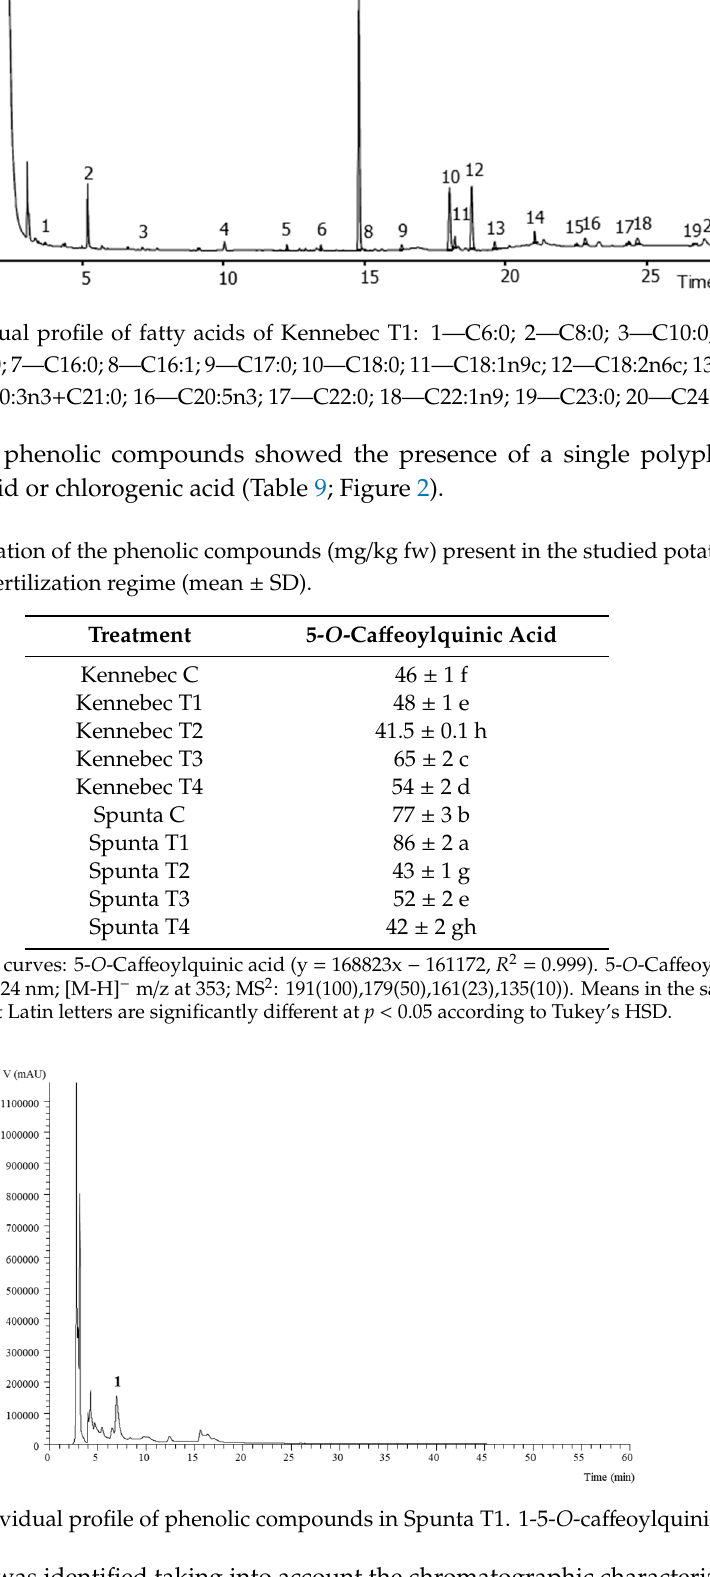
Figure 2. Individual profile of phenolic compounds in Spunta T1. 1- 5- O -caffeoylquinic acid.